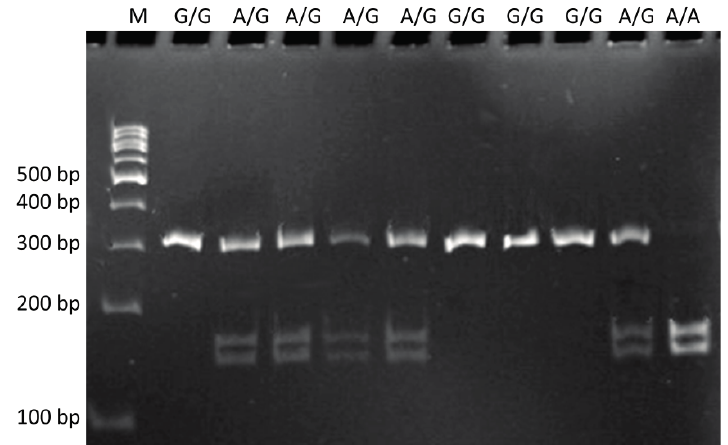
Figure 1. Restriction fragment length polymorphism analysis of the FEN1 c.–441G>A (rs174538) polymorphism. Genotypes are indicated in the upper part of the picture. Lane M is a GeneRuler™ 100-bp marker